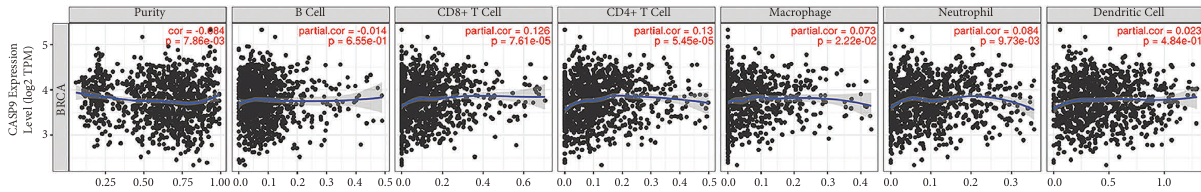
Figure 6: Correlation of CASP9 expression with immune infiltration level in breast cancer. CASP9 expression is negatively correlated with tumor purity and infiltrating level of B cells and has significant positive correlations with infiltrating levels of CD8+ T cells ( r � 0.126, P � 7 . 61 e − 05), CD4+ T cells ( r � 0.13, P � 5 . 45 e − 05), macrophages ( r � 0.073, P � 2 . 22 e − 02), neutrophils ( r � 0.084, P � 9 . 73 e − 03), and dendritic cells ( r � 0.023, P � 4 . 84 e − 01) in breast